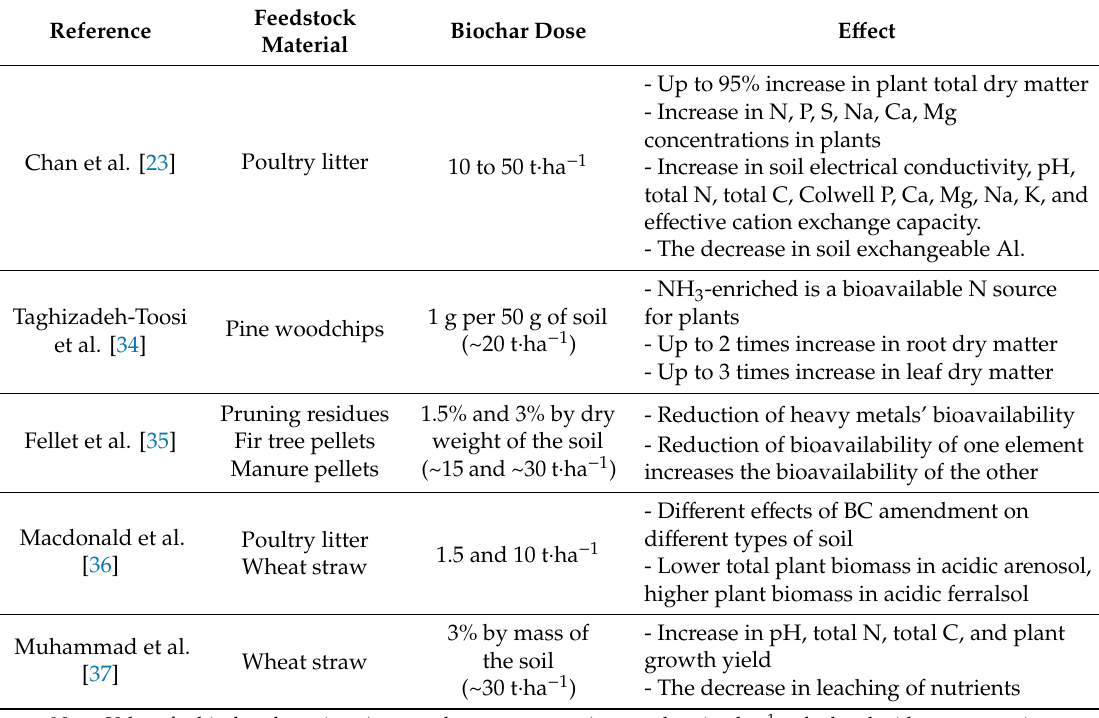
Table 2. Summary of selected data on biochar application to